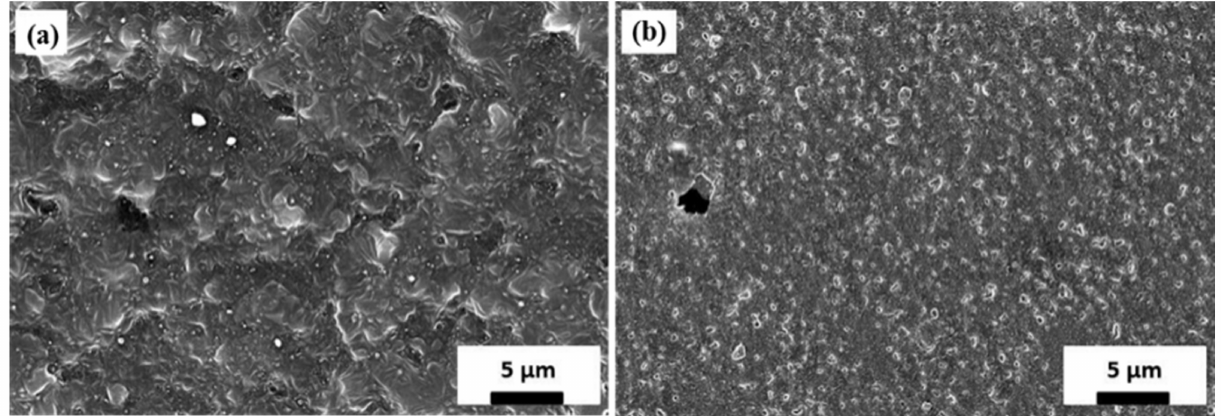
Figure 7. SEM micrographs of as-deposited pure Li layer surfaces fabricated under comparable conditions, as for the samples in Figure 6, but without applying a plasma pre-treatment prior to coating. The almost compact morphology changes slightly by increasing the substrate temperature from ≈ 50 ◦ C ( a ) to ≈ 150 ◦ C ( b ).